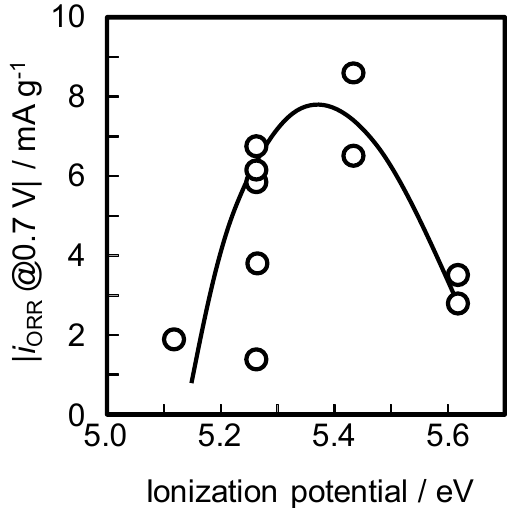
Figure 10. Relationship between the ionization potential and the i ORR @ 0.7 V of the catalysts prepared under reductive